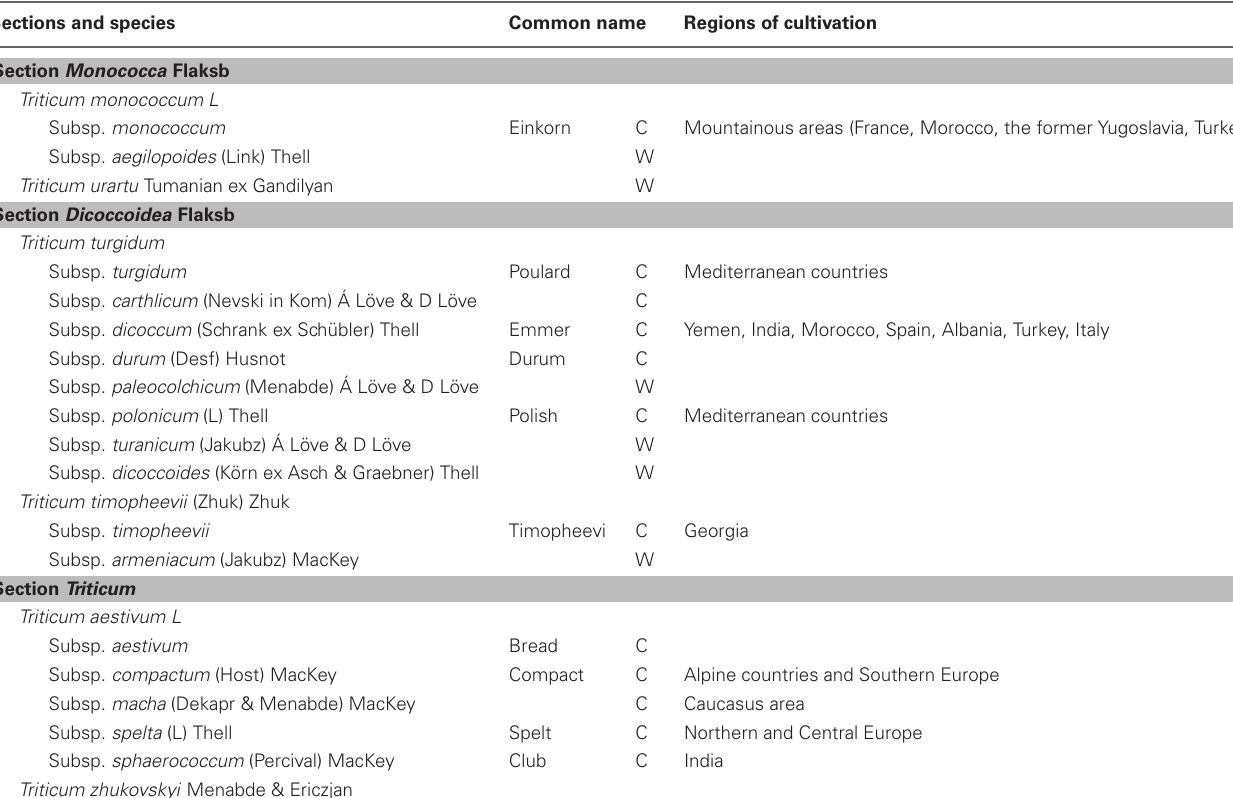
Table 1 | Cultivated species (C) within the Triticum genus, and their wild relatives (W) (Source: van Slageren, 1994). Sections and